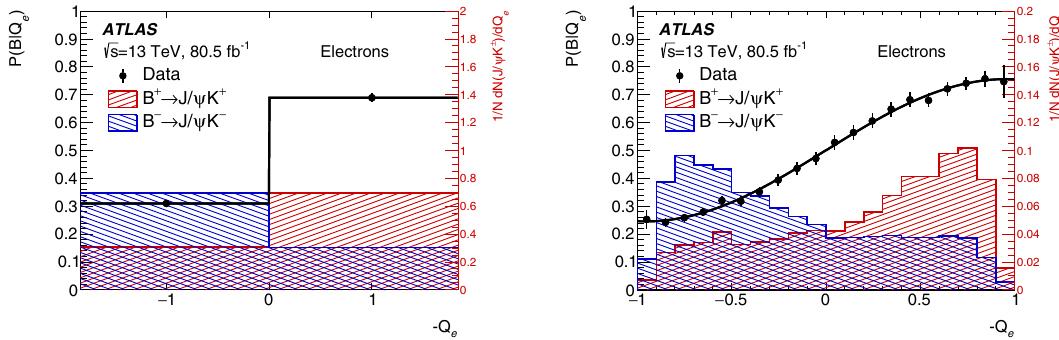
Fig. 4 Normalised cone charge distributions (shown against the right axis scale), − Q e , for B + ( B − ) events shown in red (blue) for electrons, for cases of discrete charge (left), and the continuous distribution (right). Superimposed is the distribution of the tagging probabilities, P ( B | Q e